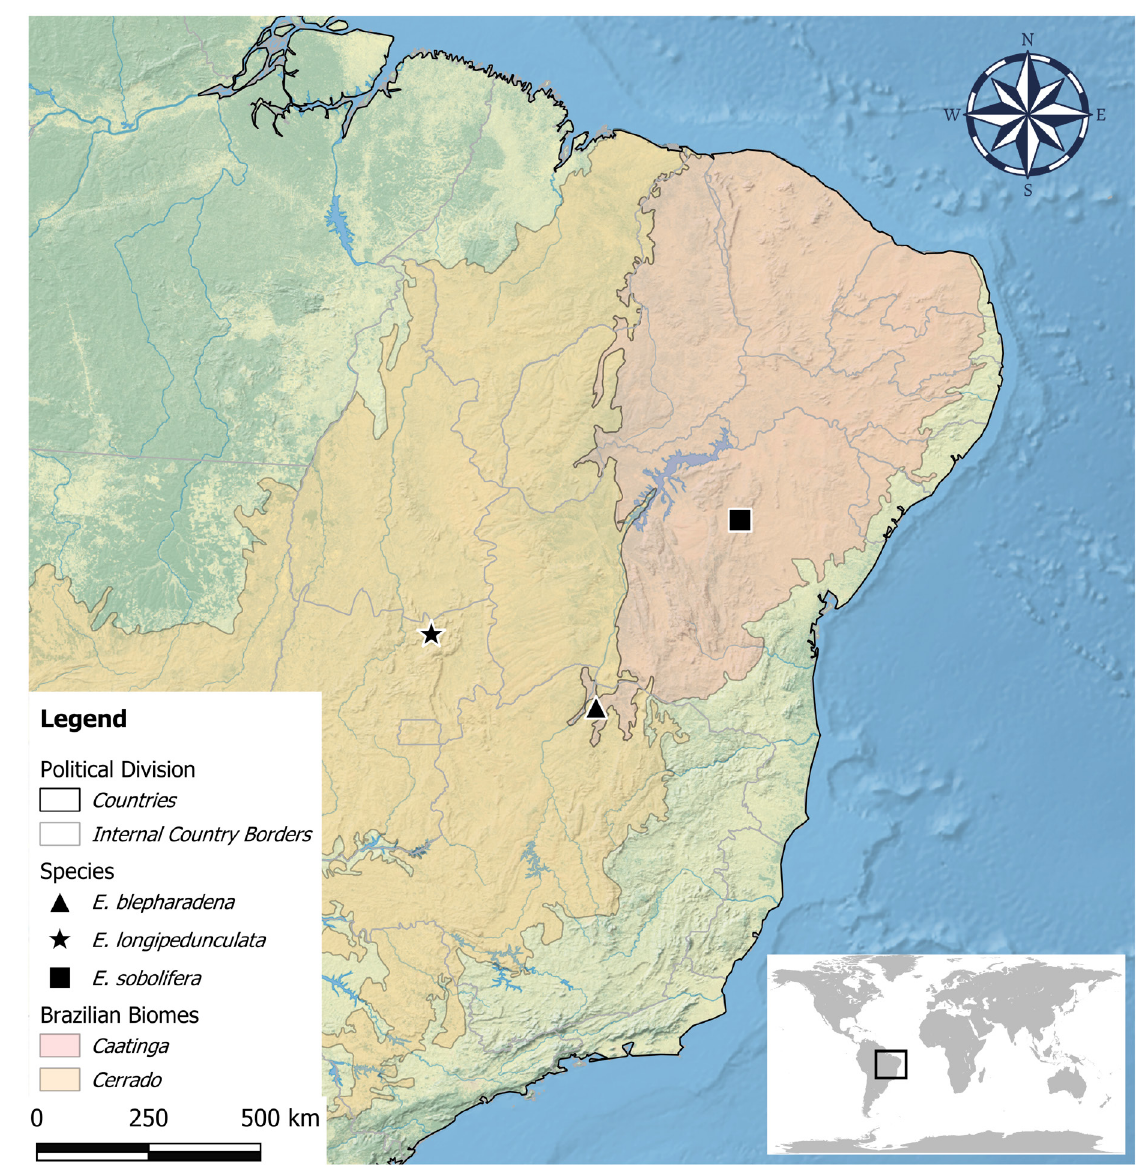
Fig. 2. Geographical distribution of Euphorbia blepharadena O.L.M.Silva & Cordeiro sp. nov. (triangle), E. longipedunculata O.L.M.Silva & Riina sp. nov. (star) and E. sobolifera O.L.M.Silva & P.J.Braun sp. nov.